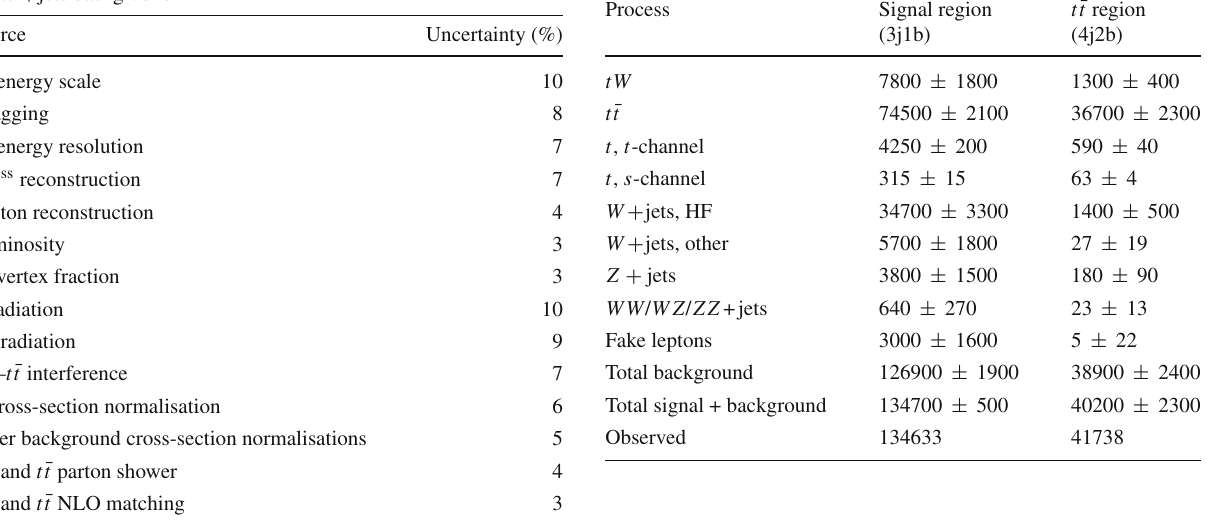
Table 2 List of systematic uncertainties considered in the analysis and their relative impact on the observed signal strength, evaluated as described in the text. The ‘model statistics’ uncertainty is dominated by the W + jets background